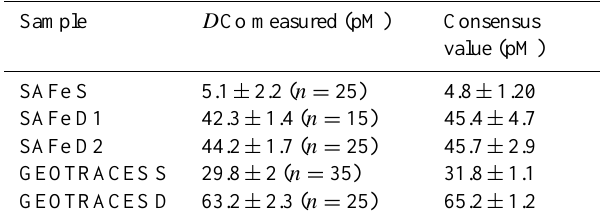
Table 1. Comparison of dissolved cobalt analyses obtained in the UV-oxidized samples by the FIA-chemiluminescence method used in the present study with consensus values reported by the Sampling and Analysis of iron (SAFe) and GEOTRACES programs. Water samples provided by SAFe and GEOTRACES from surface waters (SAFe S and GEOTRACES S) and deep waters (SAFe D1 and D2, and GEOTRACES D) were analyzed. Errors are given as standard deviation from average